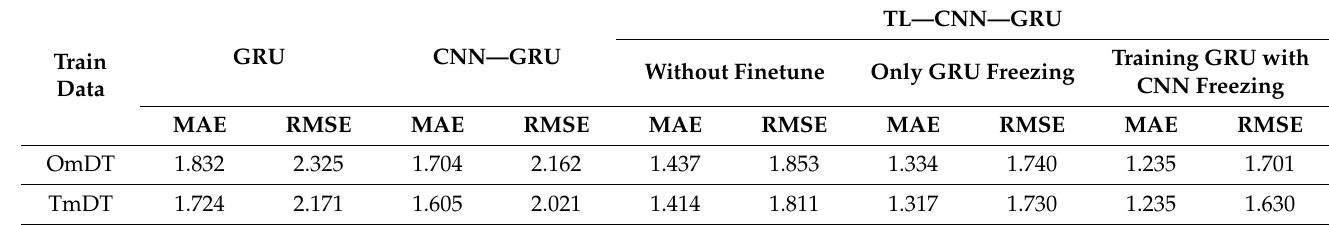
Table 2. Evaluation index accuracy of different model